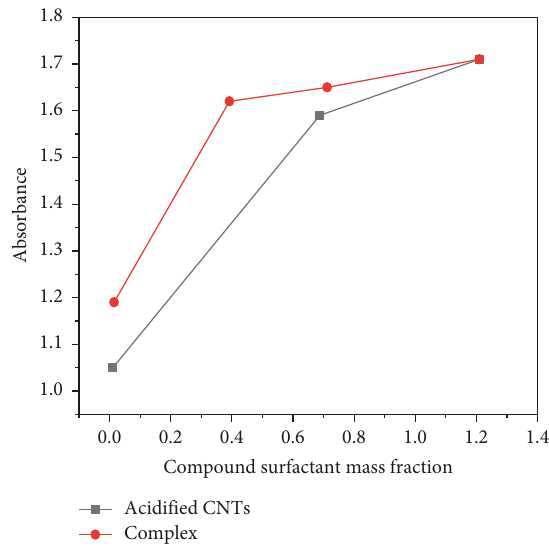
Figure 4: Influence of mass fraction of complex surfactant on absorbance of the